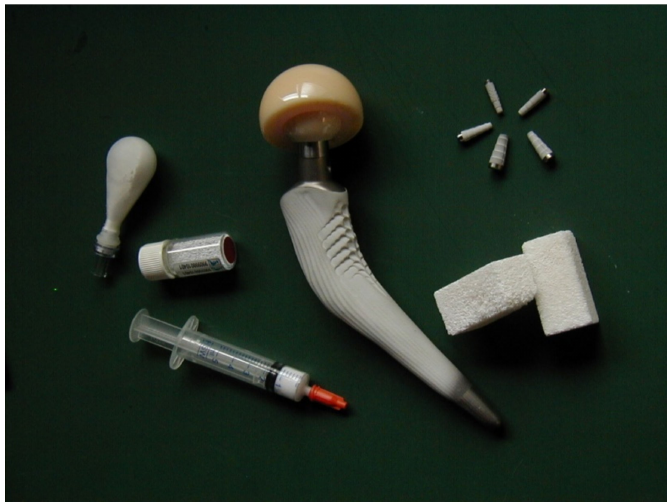
Figure 1. Several examples of the commercial CaPO 4 -based